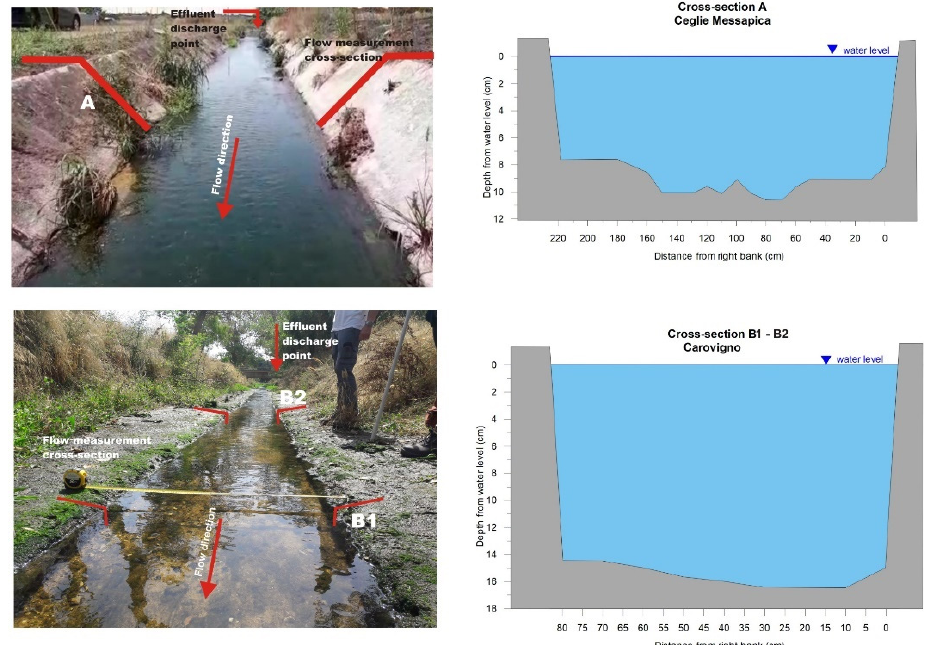
Figure 5. Flow measurement cross-sections of Ceglie Messapica (A) and Carovigno (B1 and B2) (for location see Figure 3). The surveyed geometry for cross-sections B1 and B2 is very similar, due to the regular shape of the banks in that river stretch.